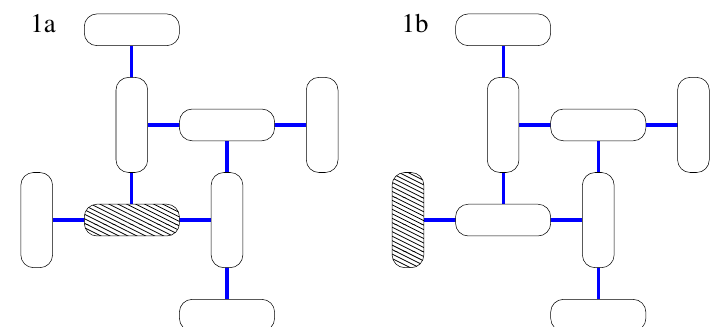
Figure 14: One-triplon configurations of the local Hamiltonians